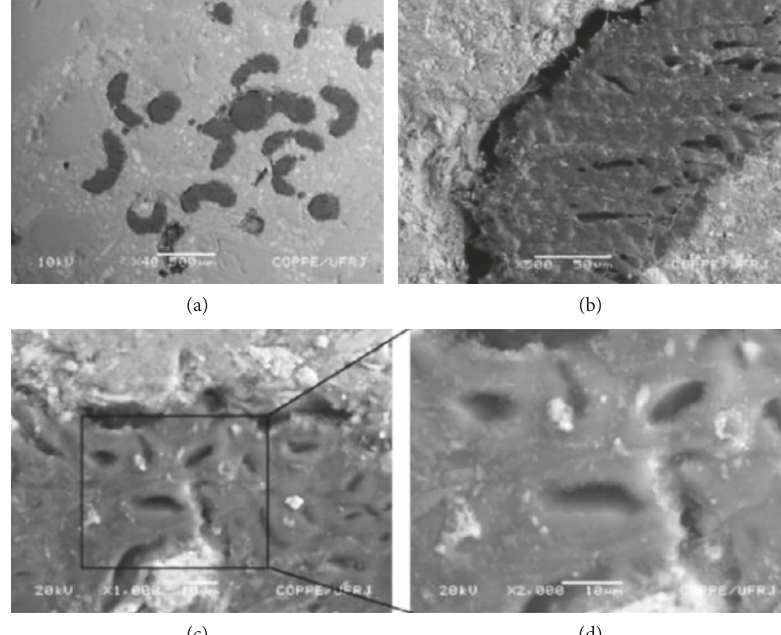
Figure 5: Micrographs of calcium hydroxide-free sisal-reinforced specimens: (a) specimens subjected to 25 wetting and drying cycles; (b) zoom-in sisal fiber subjected to 25 cycles; (c) and (d) close-up view of the sisal fiber cells in specimens subjected to 50 cycles of wetting/ drying [87]. Reproduced with permission from